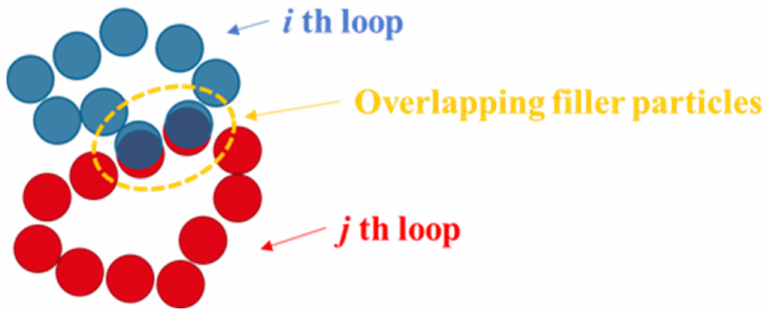
Figure 16. Schematic illustration of the filler particles belonging to multiple loops. The blue and red circles denote the filler particles constituting different loops. The particles surrounded by the orange circle belong to both the i -th and j -th loops connected physically. However, these two loops are considered different